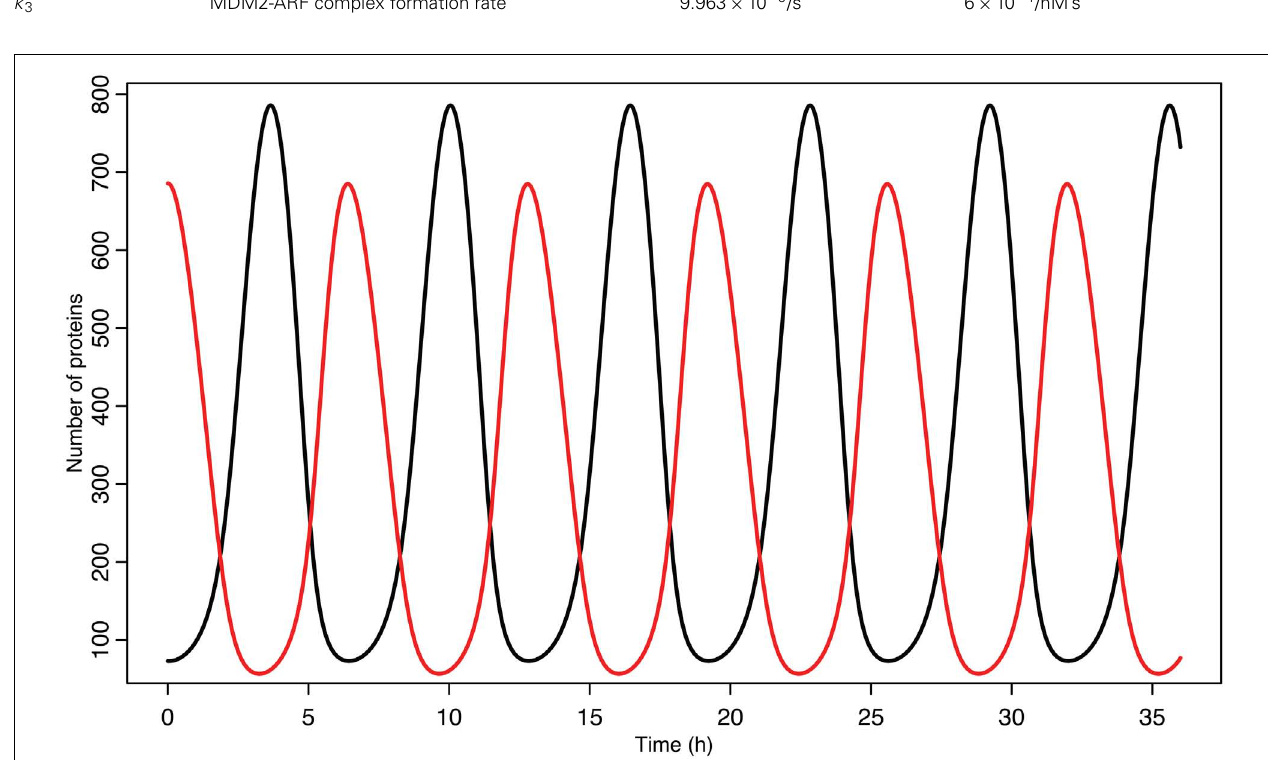
FIGURE 4 | p53 and MDM2 oscillating in the deterministic model. p53 is in black, MDM2 is in